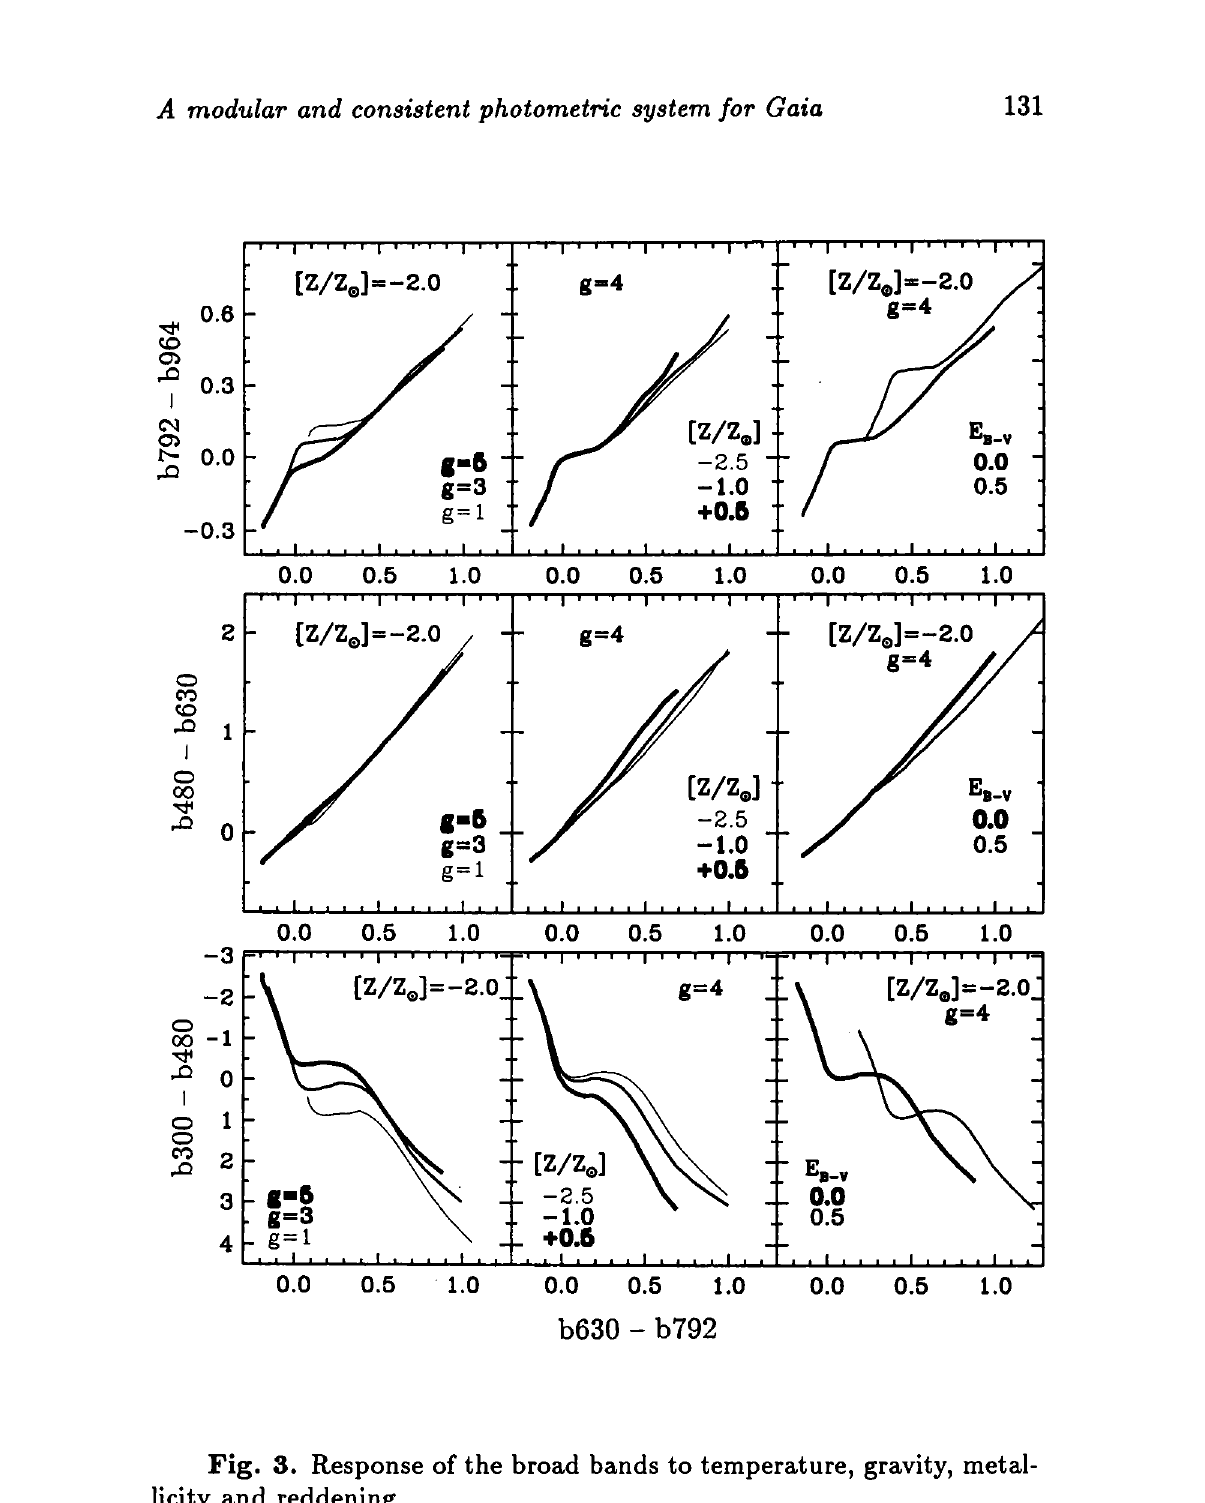
Fig. 3. Response of the broad bands to temperature, gravity, metal- licity and